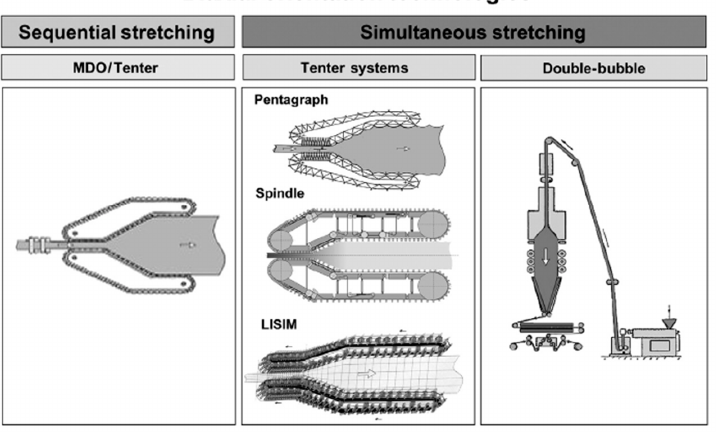
Figure 5. Schematics of sequential and simultaneous biaxial stretching processes. Reproduced with permission from [33].